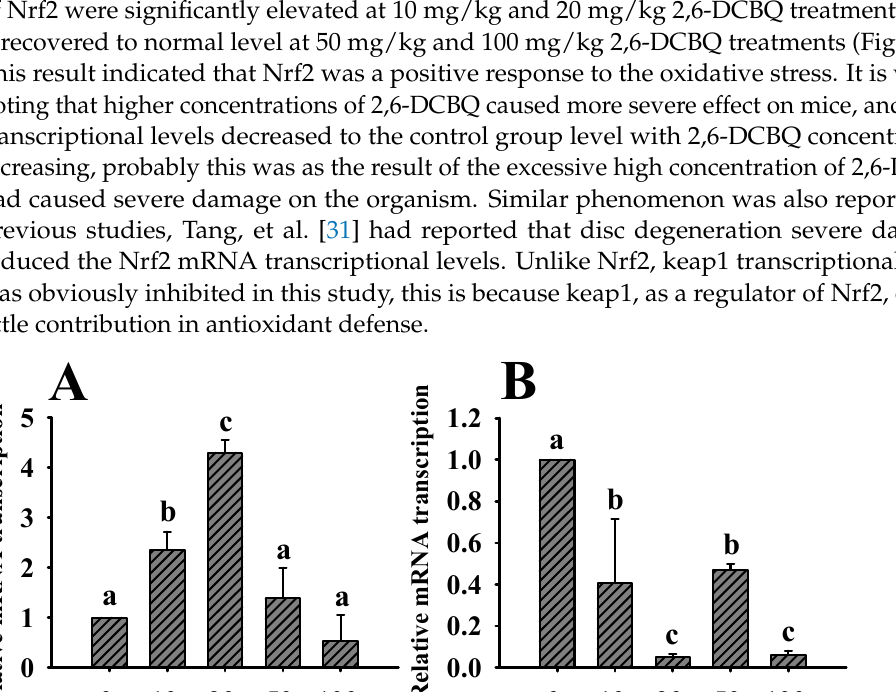
Figure 1. Changes in the activities of SOD ( A ) and CAT ( B ) of mice under different 2,6 ‐ DCBQ con ‐ centrations after 30 d of exposure. Values are plotted as the mean ± SD, and different letters denote significant difference at p < 0.05.